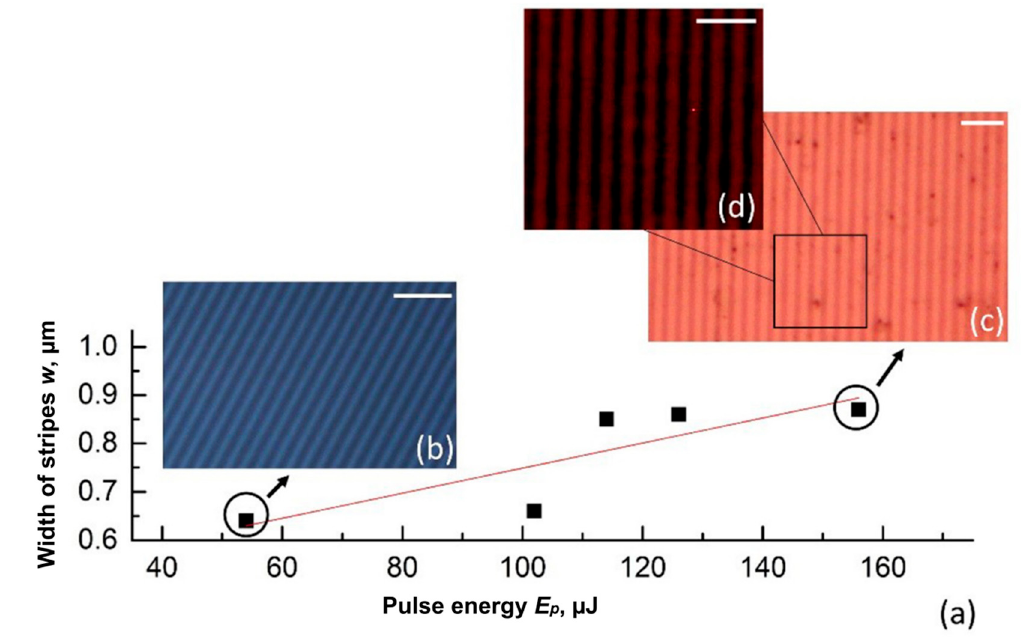
Figure 4. ( a ) The width of stripes ( w ) versus laser pulse energy ( E p ). ( b , c ) Micro photos of oxidized periodical stripes in reflection light and ( d ) in transmission light. Scale bar is 5 µ m.